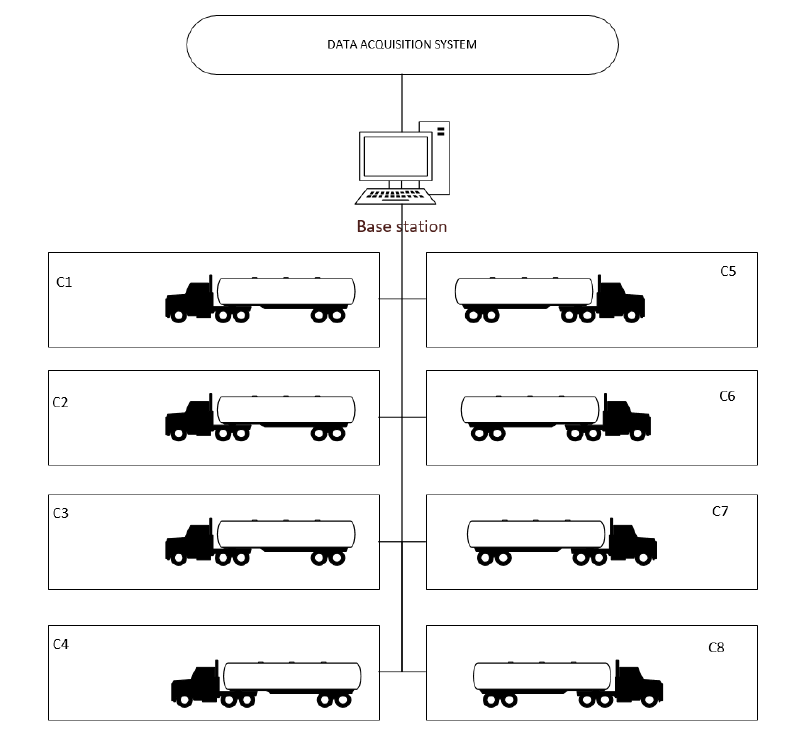
Figure 9. Example of storage tank facility with trailer attached